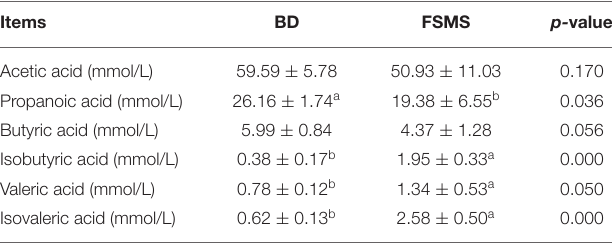
TABLE 5 | Influence of FSMS addition on porcine colon digesta volatility fatty acids (VFAs) production. Items BD FSMS p- value Acetic acid (mmol/L) 59.59 ± 5.78 0.170 Propanoic acid (mmol/L) 26.16 ± 1.74 a Butyric acid (mmol/L) 5.99 ± 0.84 Isobutyric acid (mmol/L) 0.38 ± 0.17